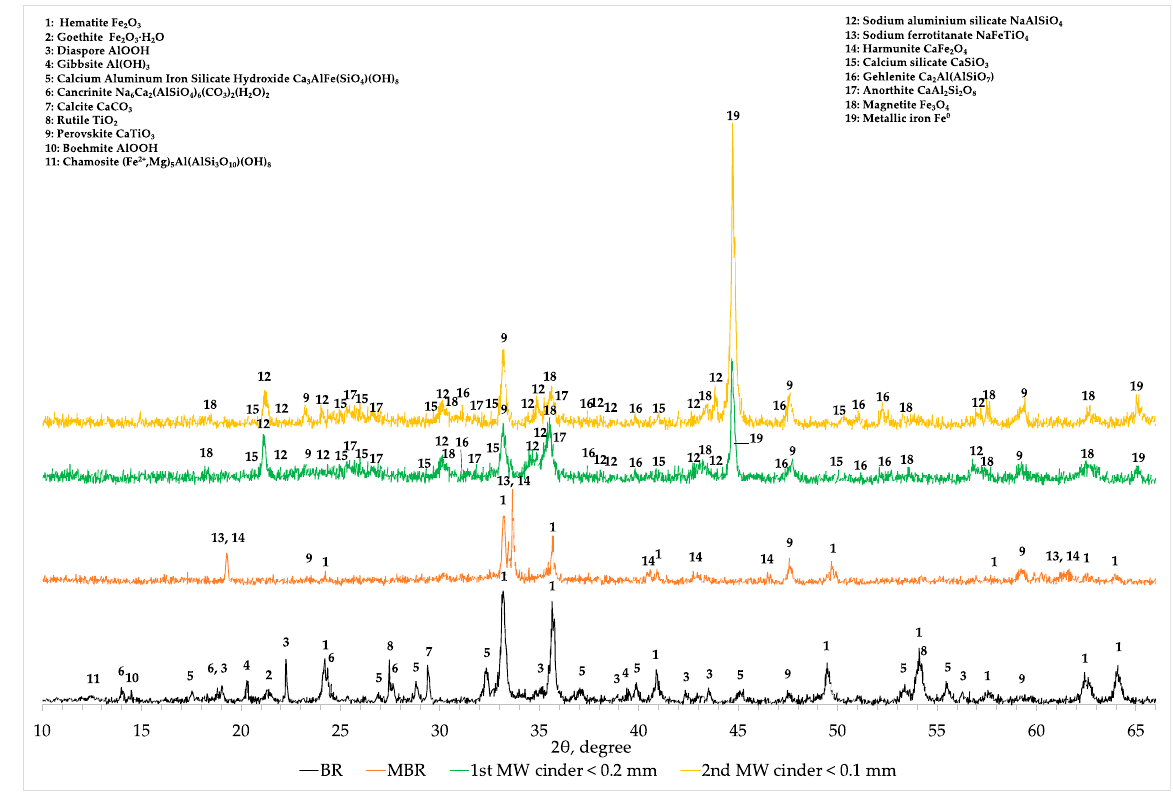
Figure A1. Comparison of XRD profiles of bauxite residue, modified BR and 1st cinder fraction with particle size <0.2 mm.